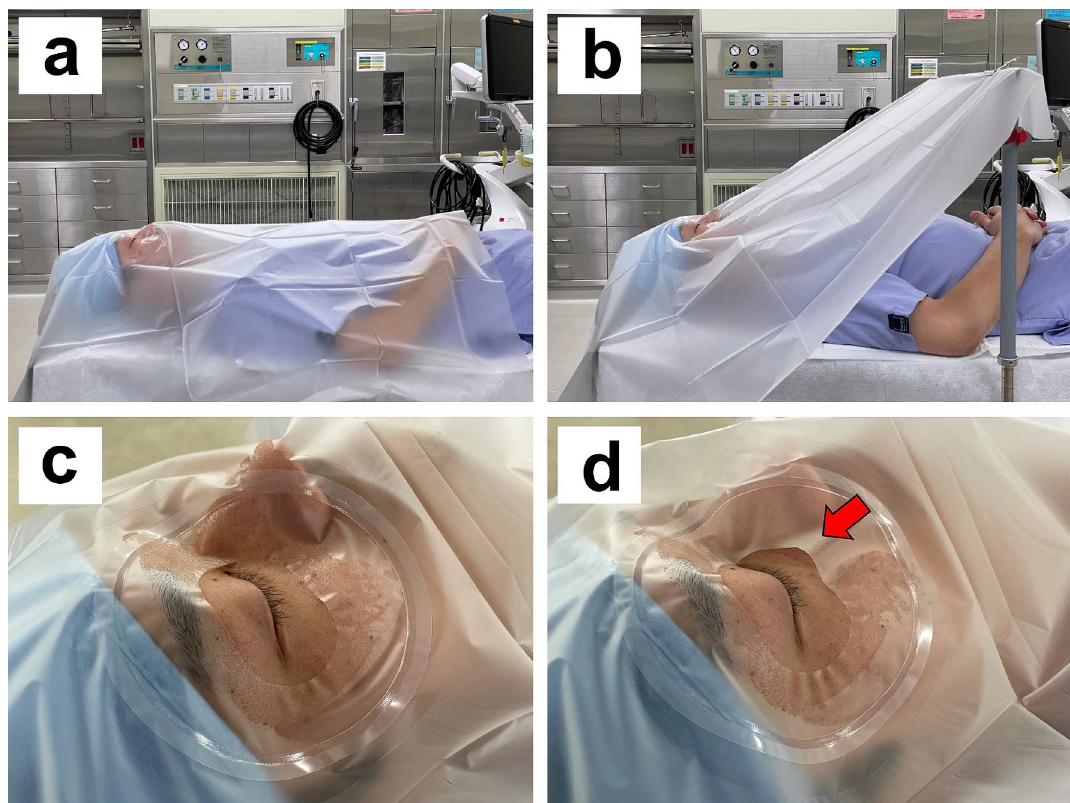
Figure 2. Overview of the experiment and the periocular region after draping. ( a ) The drape was not hung in experiment patterns 1 and 2. ( b ) The drape was hung with the rihika, and there was a space above the chest in experiment pattern 3. ( c ) The adhesive part of the drape completely adhered in experiment pattern 1. ( d ) A quarter of the adhesive part of the drape was peeled off (red arrow; the nasal inferior part; width, 30 mm) in experiment patterns 2 and